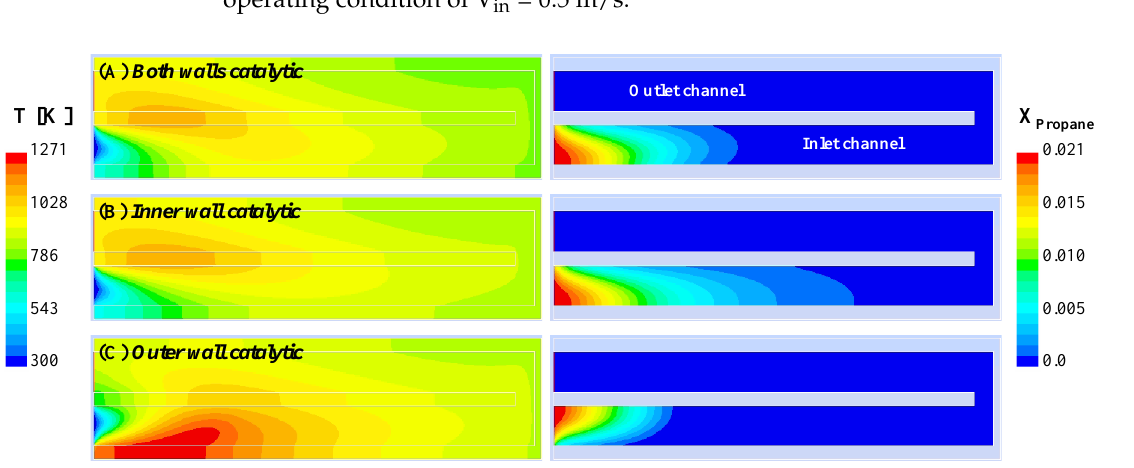
Figure 2. Contours of temperature, T [K], and propane mole fraction, X Propane , for the three reactor configurations of Figure 1 with different catalyst placement. Low thermal conductivity (3 W/(m K)) and V in = 0.5 m/s. The computational domain is scaled along the transverse direction by a factor of 2 for better